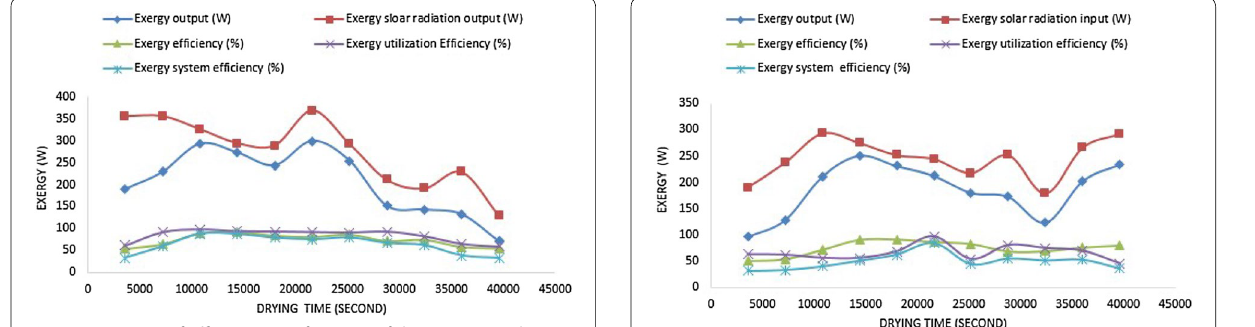
Fig. 19 Variation of efficiency as a function of drying time and exergy in the drying chamber (3rd day) potato